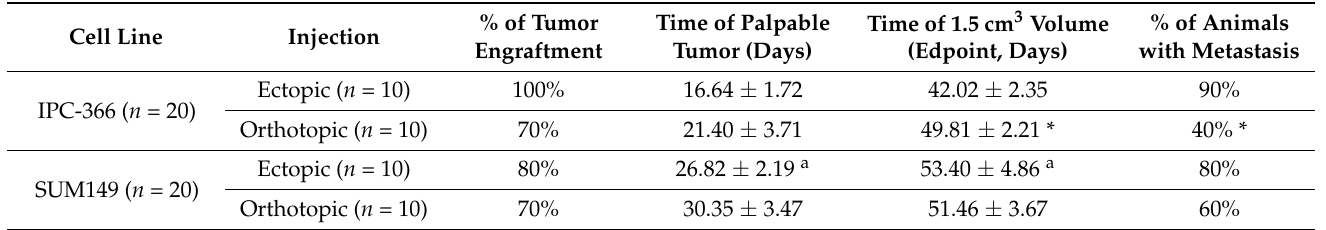
Table 1. Tumor growth parameters of IPC-366 and SUM149 cell lines in ectopic and orthotopic models.